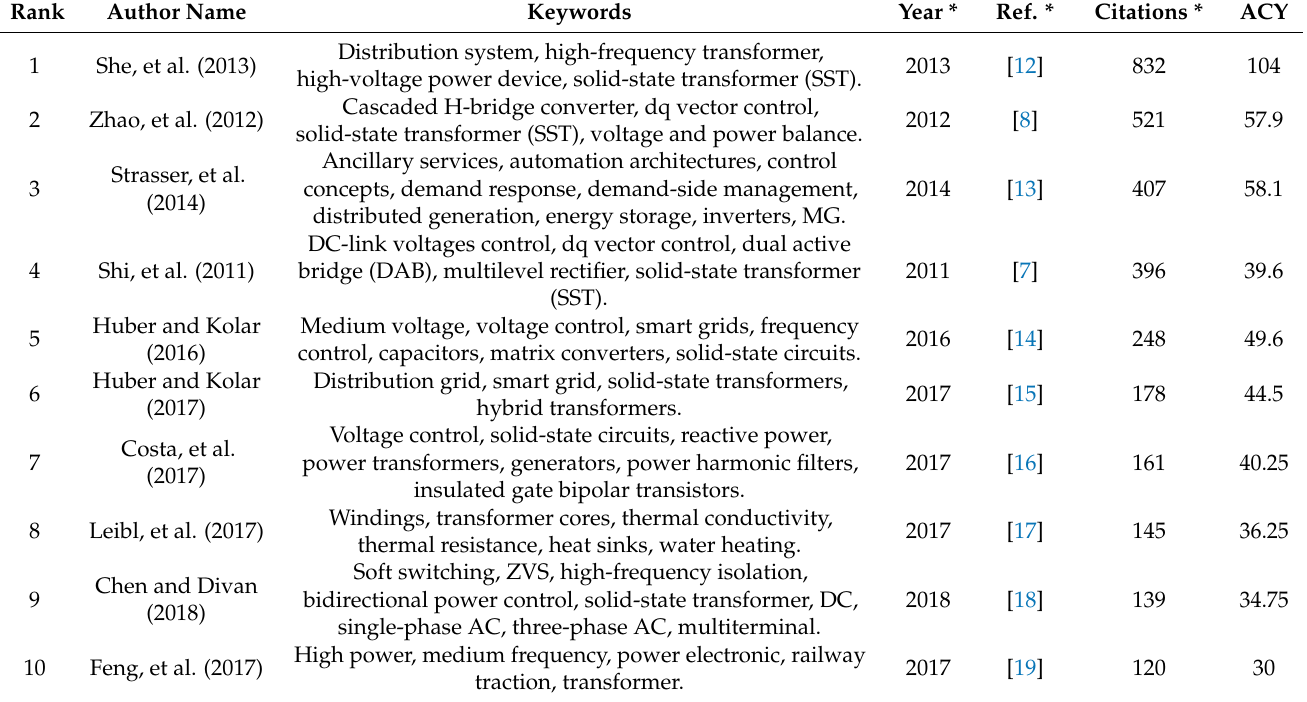
Table 2. Summary of Top Ten Articles Based on the Highest Number of Citations in the past 5